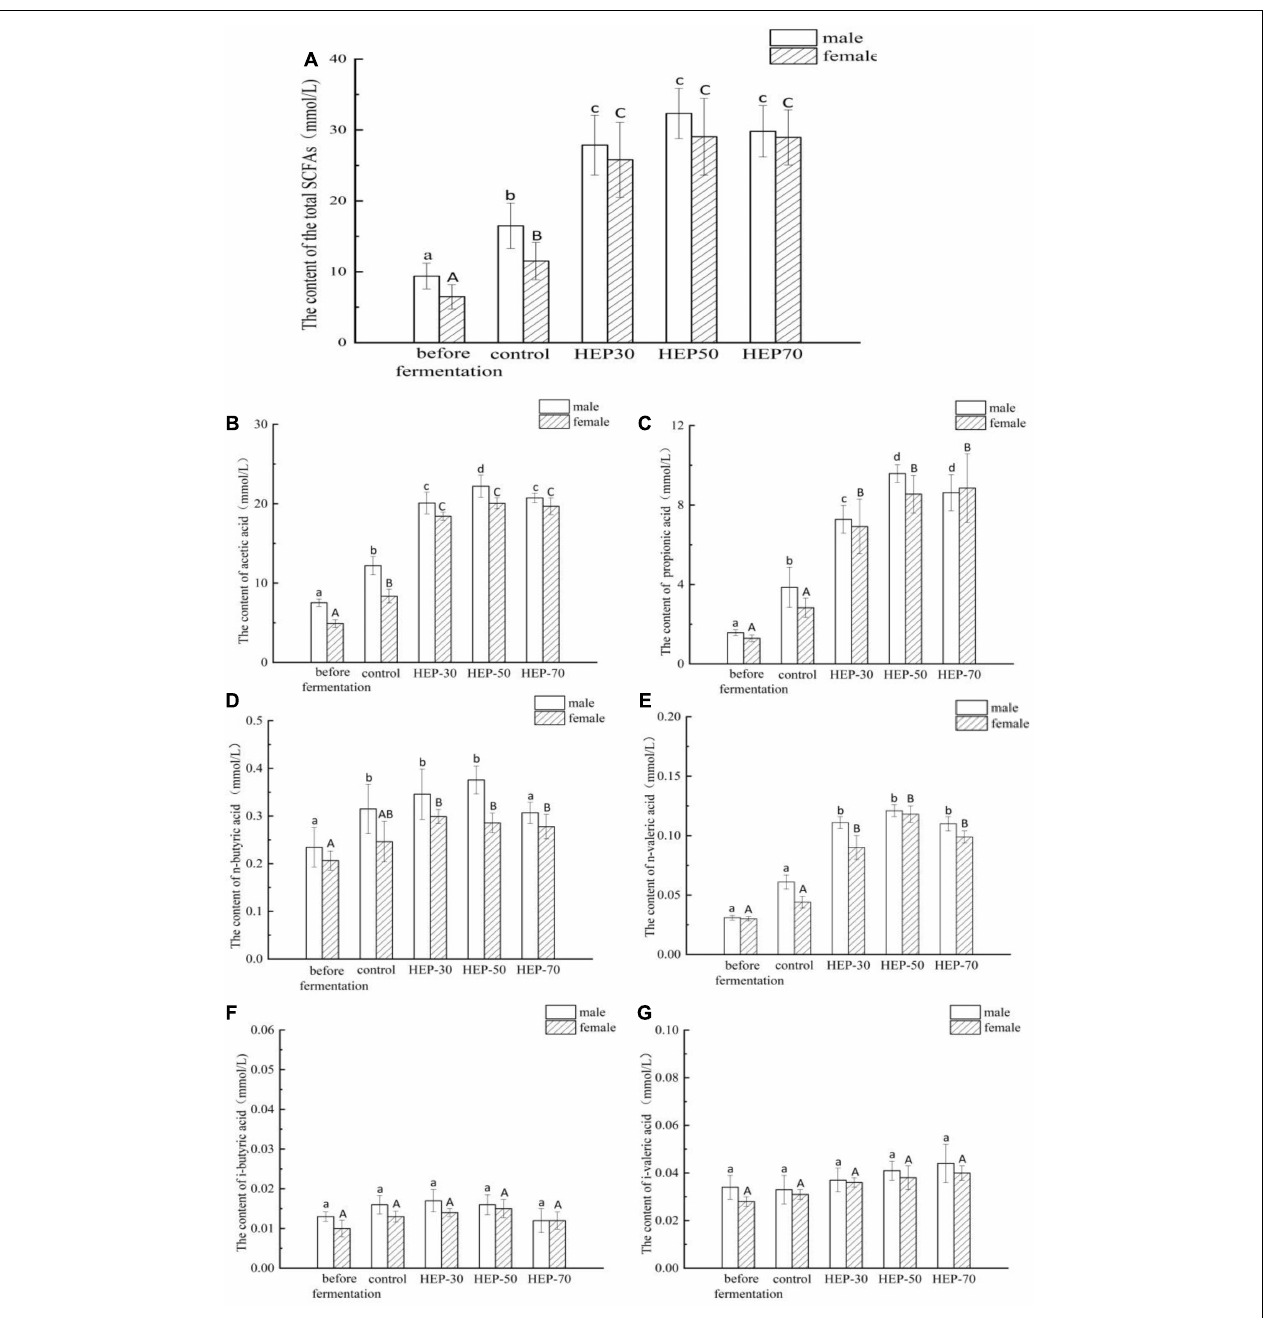
FIGURE 4 | The short-chain fatty acid (SCFA) concentrations of different groups in the feces before or after fermentation. (A) total SCFAs; (B) acetic acid; (C) propionic acid; (D) n-butyric acid; (E) n-valeric acid; (F) i-butyric acid; (G) i-valeric acid. Data are means ± SD (3 independent experiments × 3 replication). Different letters (without a common letter) indicated a significant difference between the two experimental groups ( p < 0.05). a , b , c , d Lowercase and A , B uppercase letters indicate the significance of HEPs on fecal microbiota fermentation of male and female volunteers,